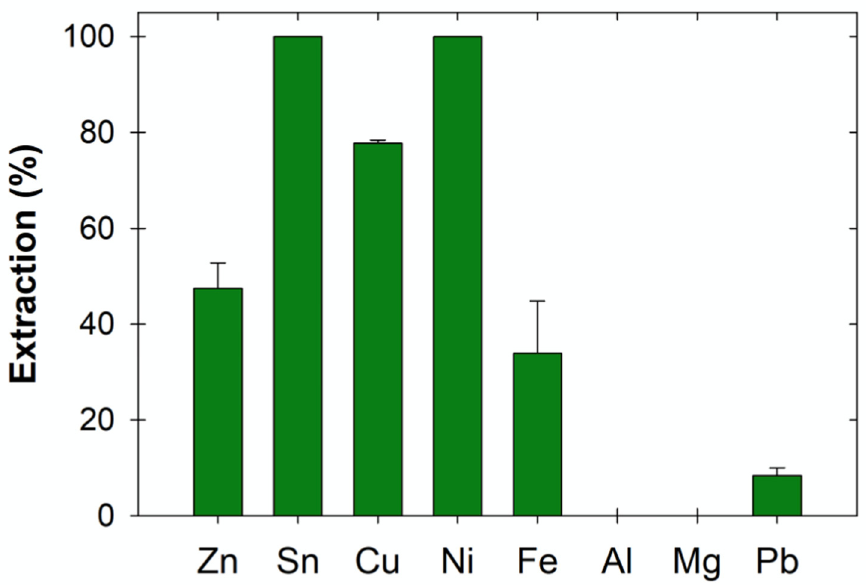
Figure 2. Extraction of metals from 1 × 1 cm 2 PCB pieces after 72 h in ChCl:EG in the presence of I 2 .